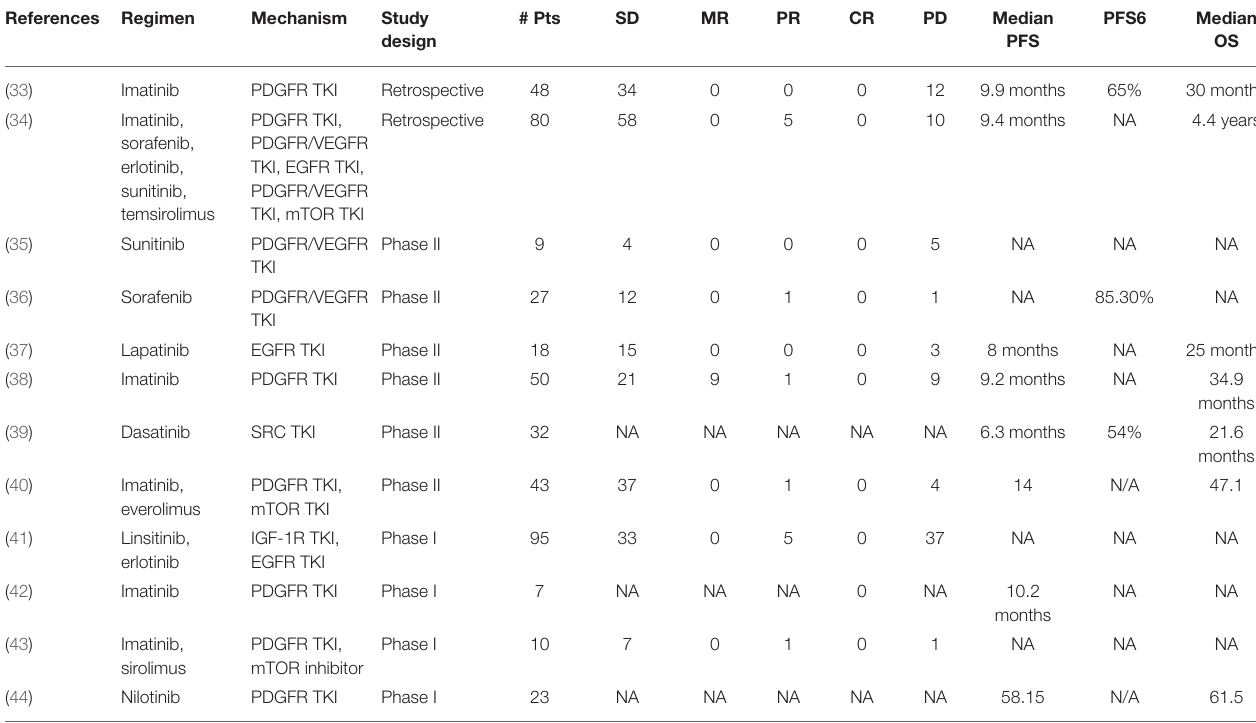
TABLE 2 | Completed clinical trials for targeted therapies in chordoma.